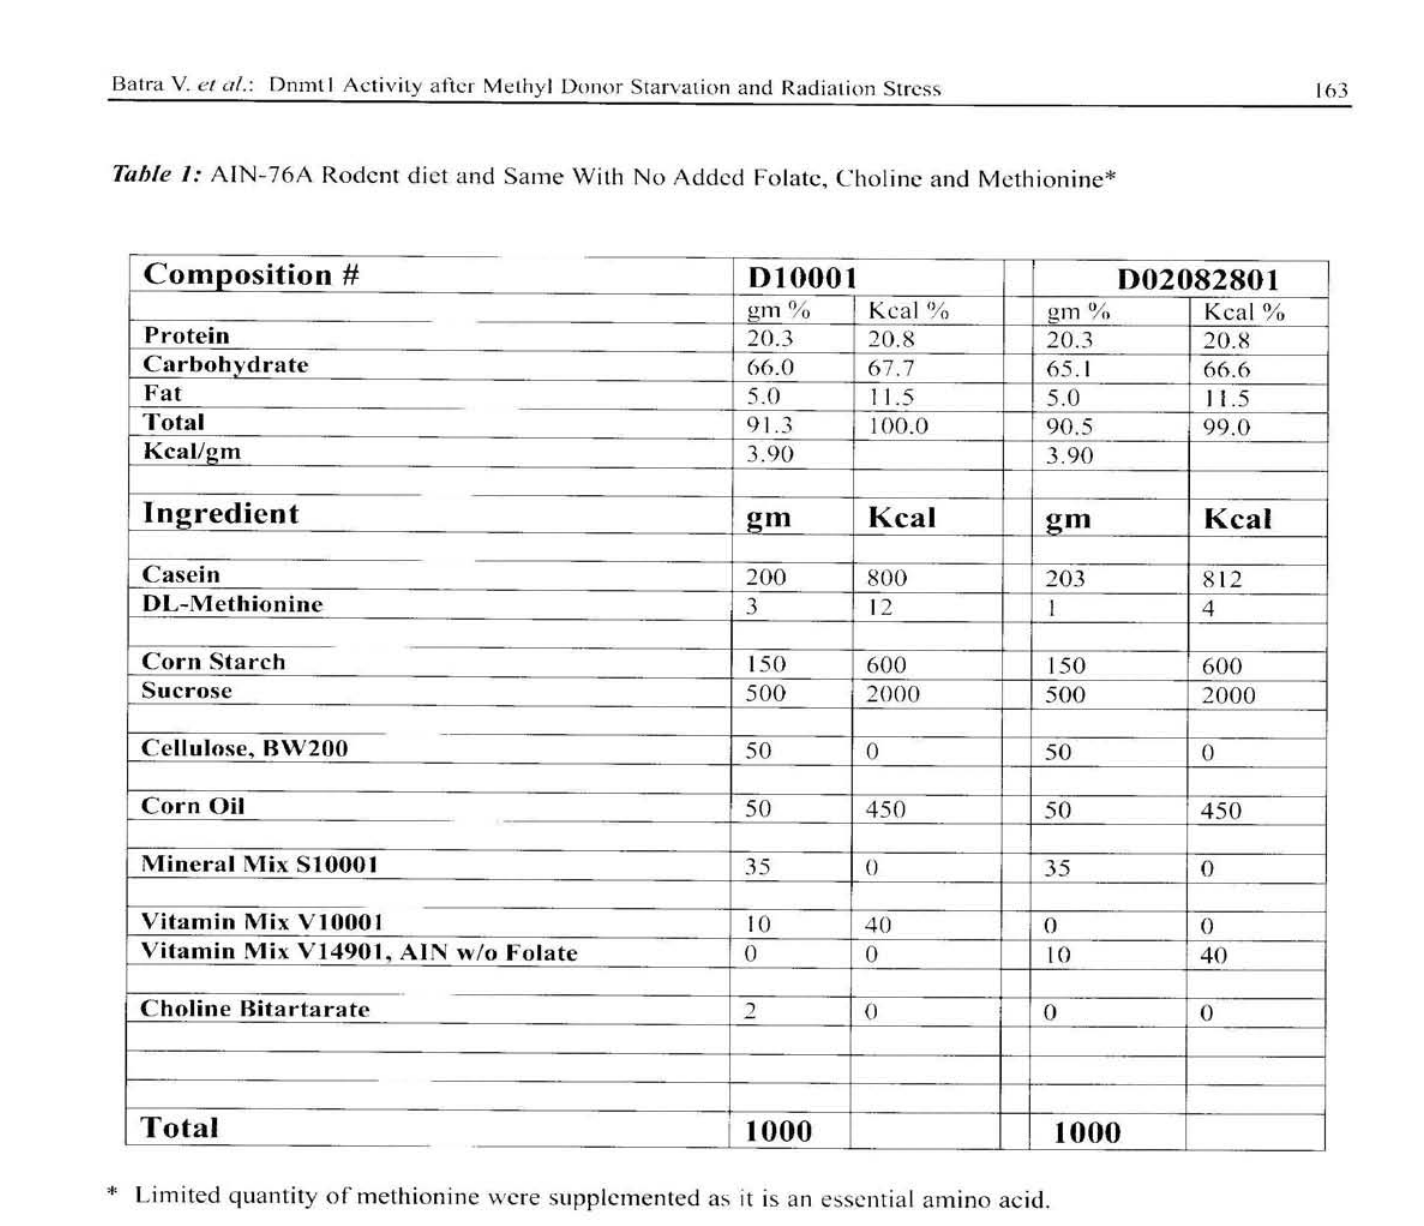
Table 1: AIN-76A Rodent diet and Same With No Added Folate, Choline and Methionine*